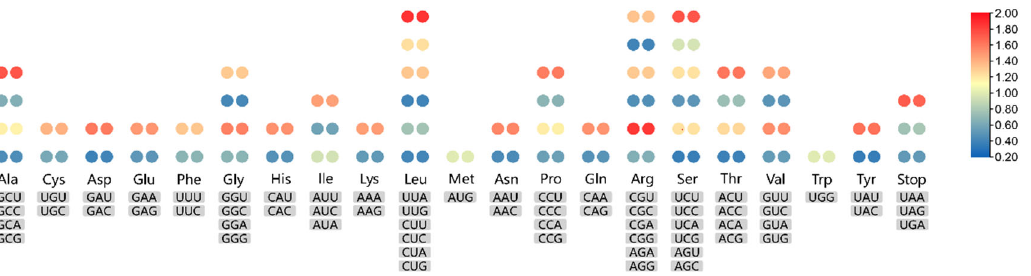
Figure 3. The RSCU values of all protein-coding genes for O. taihangensis and O. longilobus cp genomes. Color key: the red values indicate higher RSCU values, and the blue values indicate lower RSCU values. The left side represents O. taihangensis , and the right side represents O. longilobus.